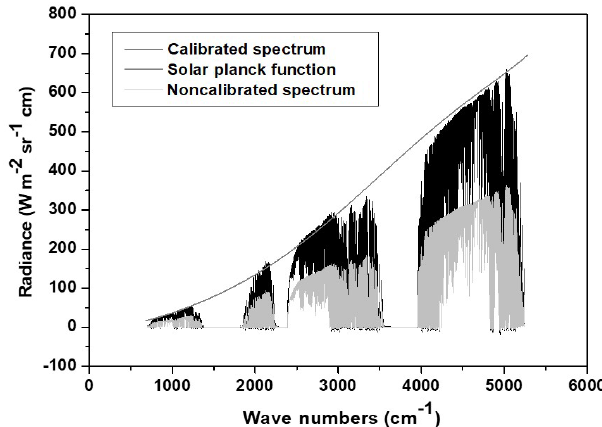
Figure 3. The calibration process transforms the noncalibrated spectrum (light gray) into a calibrated one (black) that fits with the solar Planck function (solid gray line).